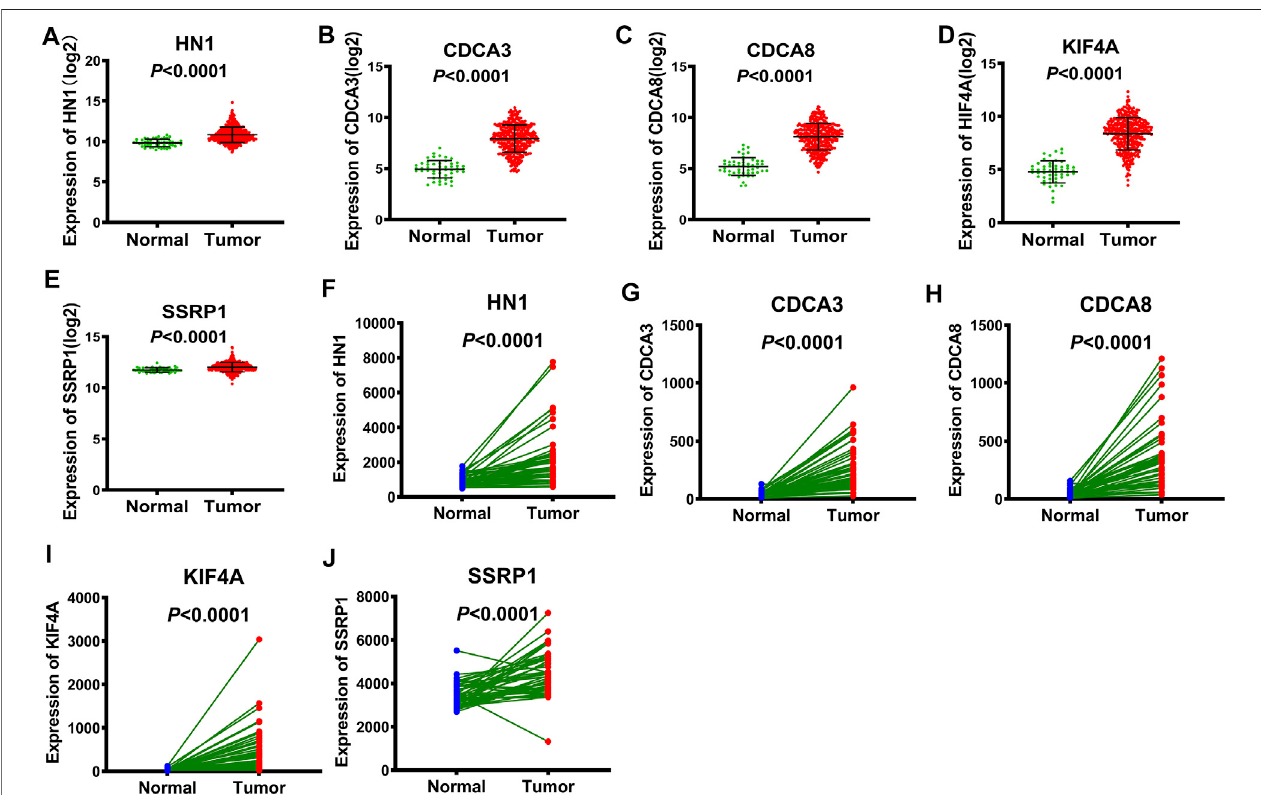
FIGURE3| Theexpression ofE2Ftarget genesintumor tissuesversusnormal tissues fromTCGA (A-E) Wilcoxon rank-sum test, theexpression ofHN1,CDCA3, CDCA8, KIF4A and SSRP1 in tumor tissues versus normal tissues, respectively. (F-J) Wilcoxon signed-rank test, the expression of HN1, CDCA3, CDCA8, KIF4A and SSRP1 in tumor tissues versus normal tissues,